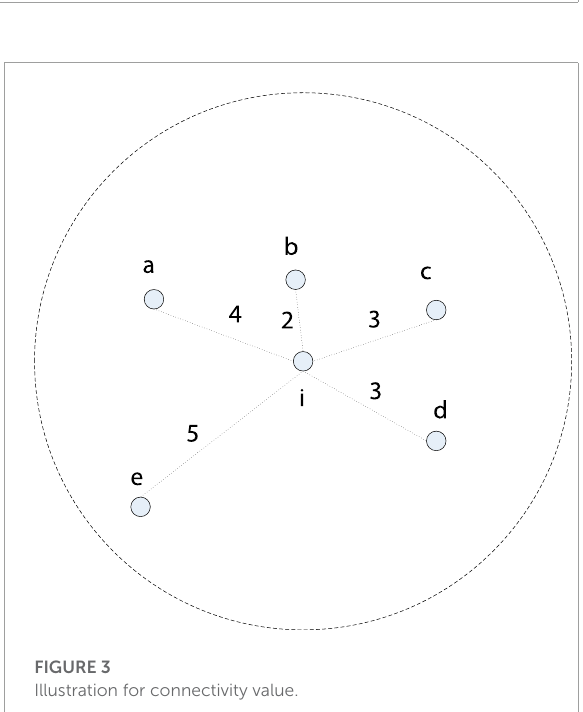
FIGURE 2 Illustration for relative stability.